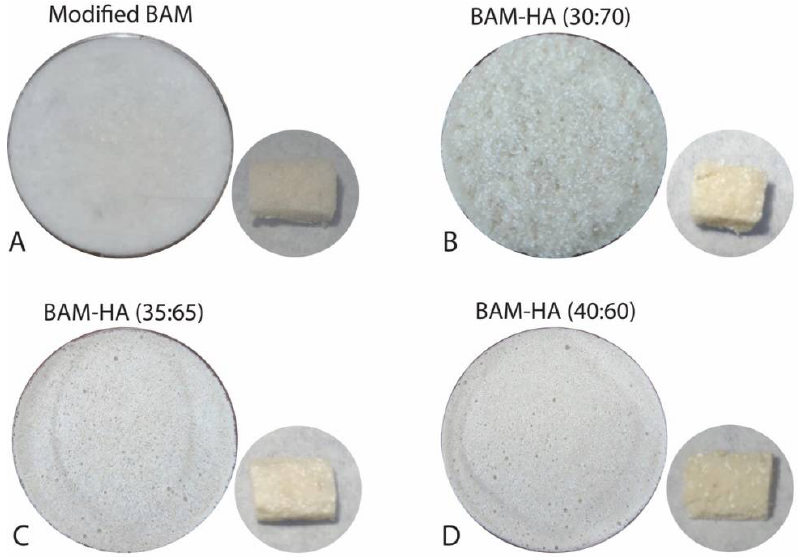
Figure 1. The bio-composite BAM–HAp with different ratios. ( A ) Modified BAM; ( B ) 30:70; ( C ) 35:65; ( D )